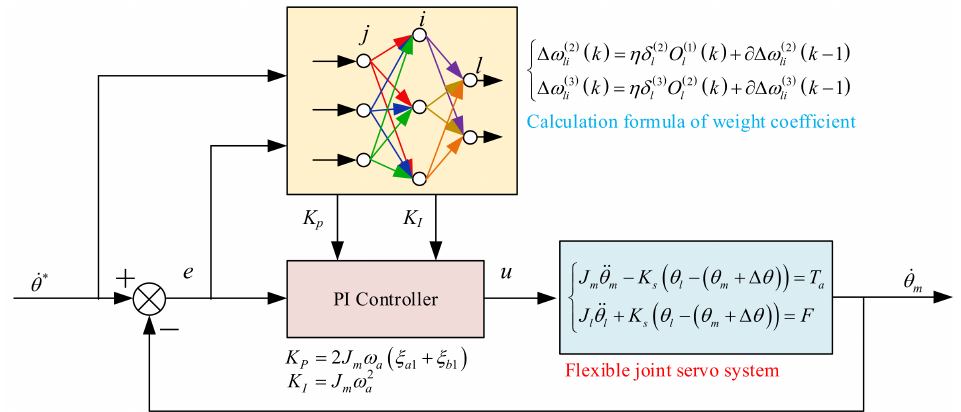
Figure 9. Control block diagram of the flexible joint servo